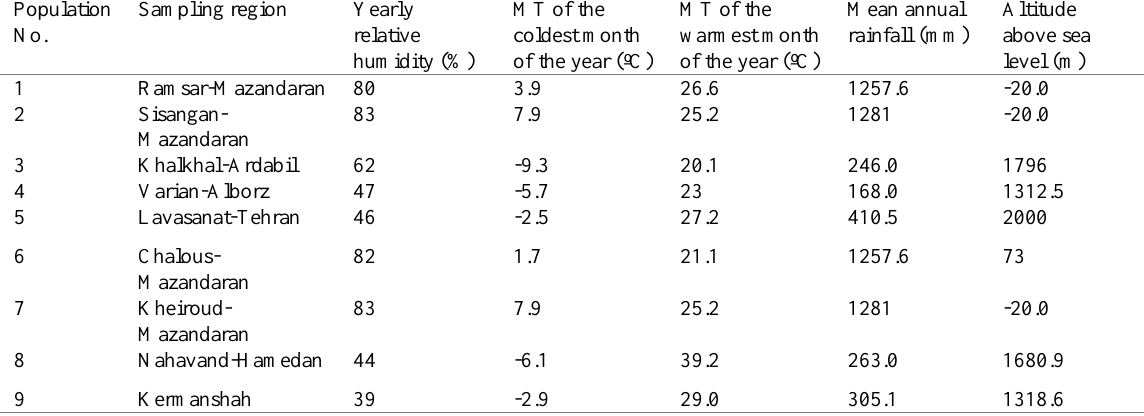
Table 1. The climate of different wild violet sampling regions in Iran (According to the information of Iran meteorology calendar of